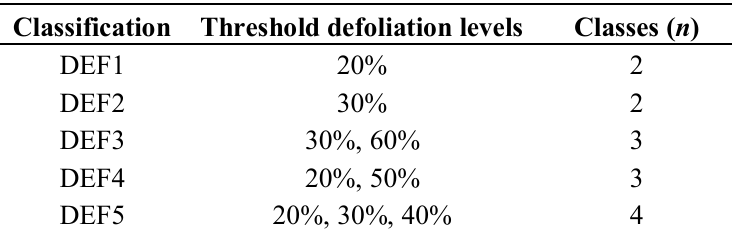
Table 2. The five different classification schemes with threshold values and number of classes in every scheme.